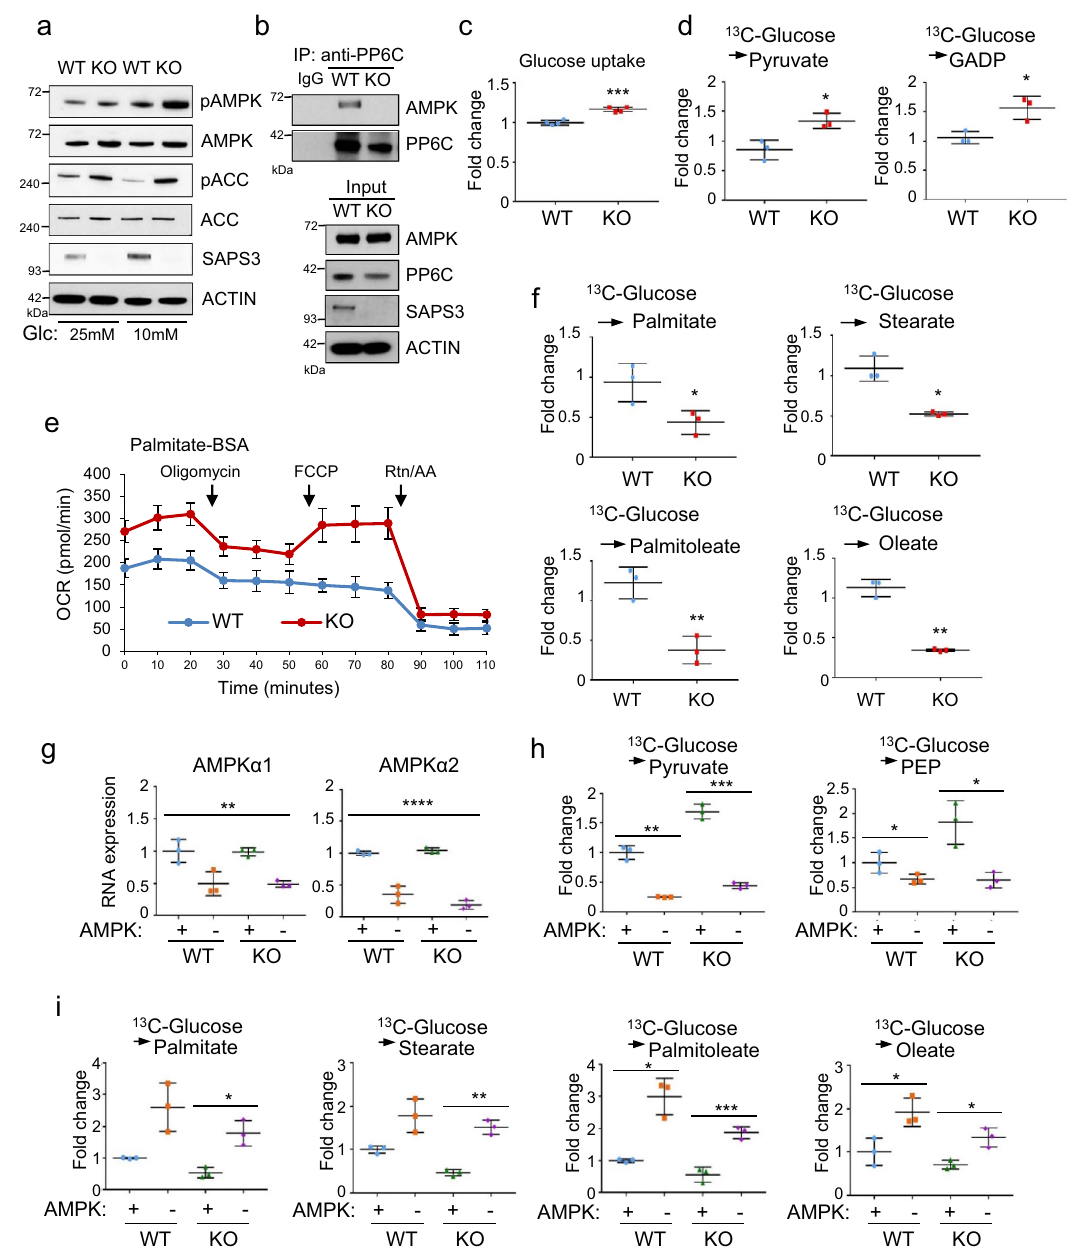
Fig. 5 | SAPS3 regulates cellular metabolism via AMPK. a pAMPK and down- streampACCweretestedbyWesternblottinginWTandSAPS3KOMEFculturedin 25mM and 10mM glucose medium. The results are representative of three inde- pendent experiments. b WT and SAPS3 KO MEF cell lysates were immunopreci- pitated with anti-PP6C antibody followed by Western blotting. The results are representativeofthreeindependentexperiments. c Glucoseuptakewasmeasured using the Nova Biopro fi le 100 analyzer. Mean±s.d., n =4 biological replicates analyzedbytwo-tailed t -test,*** p =0.0006. d U- 13 C 6 glucose-derivedpyruvateand glyceraldehyde-3-phosphate (GADP) levels in WT and SAPS3 KO MEF cells. Mean±s.d., n =3 biological replicates analyzed by two-tailed t -test. Pyruvate, * p =0.018; GADP, * p =0.028. e Fatty acid oxidation rate was measured using the XF-24 Seahorse system. Mean±s.d., n =5 biological replicates. f U- 13 C 6 glucose- derived palmitate, stearate, palmitoleate, and oleate levels in WT and SAPS3 KO